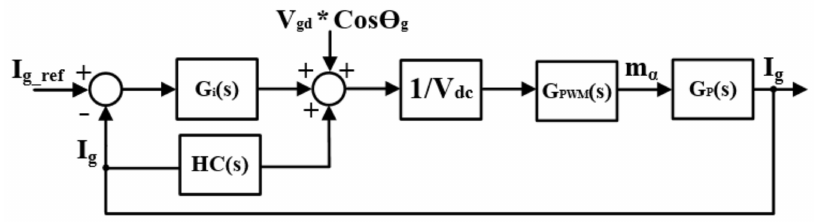
Figure 6. Simplified block diagram of the proposed harmonic compensation